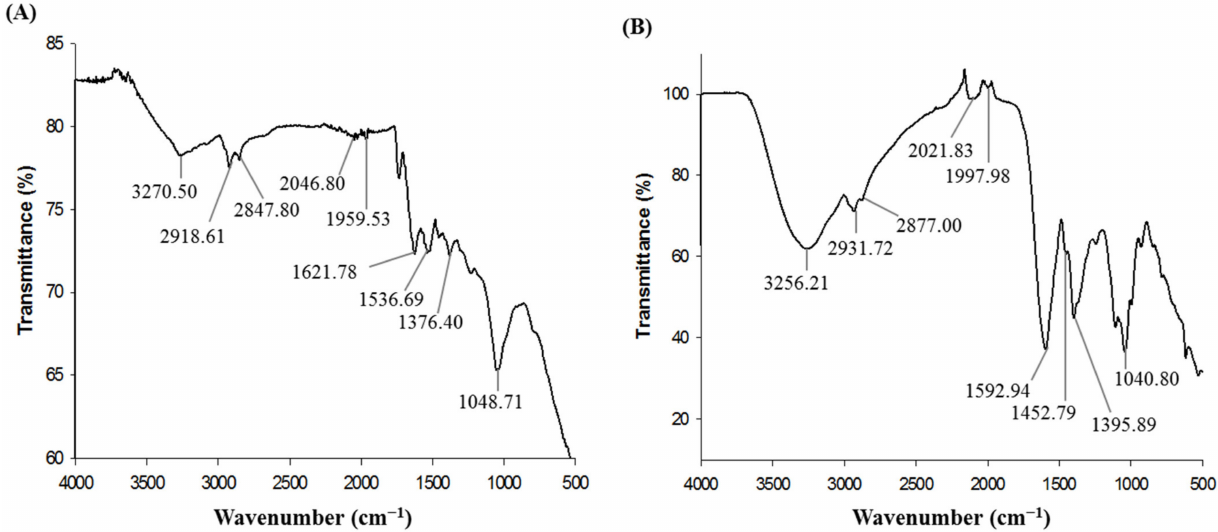
Figure 4. FT-IR spectra of Massilia sp. MAHUQ-52 mediated synthesized AgNPs ( A ) and bacterial culture supernatant ( B